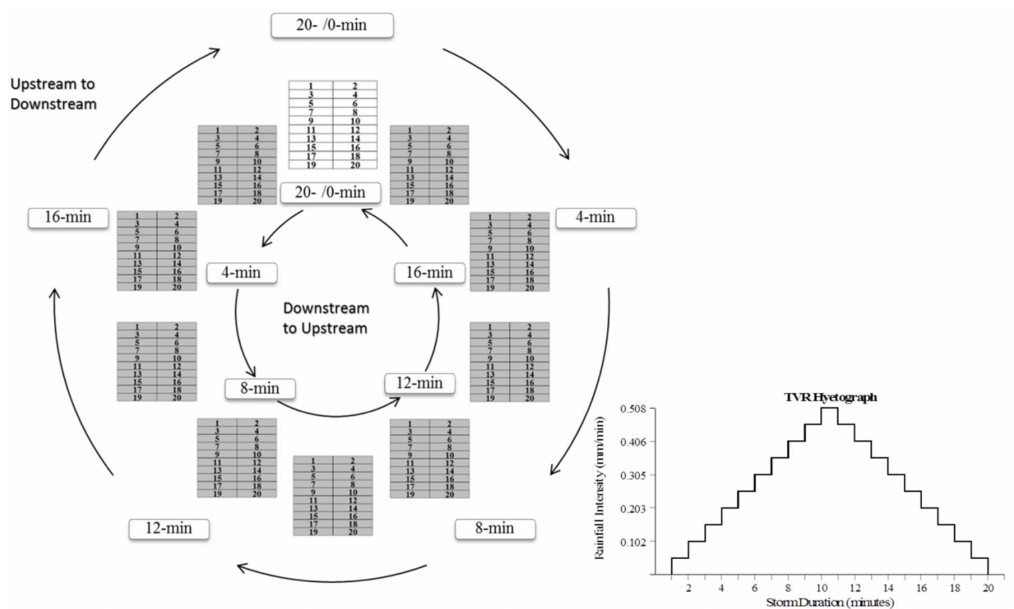
Figure 3. Temporally varied rainfall (TVR) applied to synthetic rectangular drainage basins (mean areal